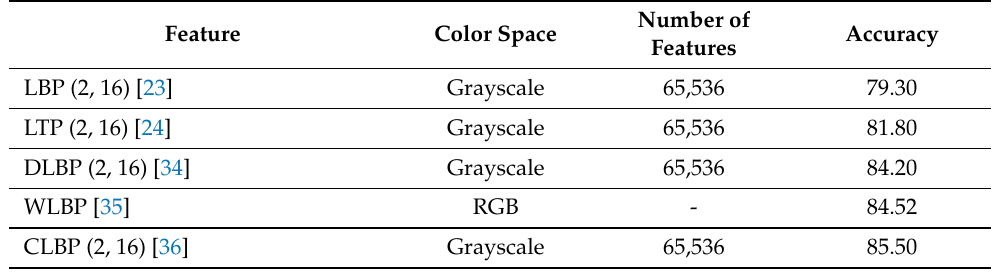
Table 3. Comparison of experimental results on SWIMCAT dataset using ICS with previous